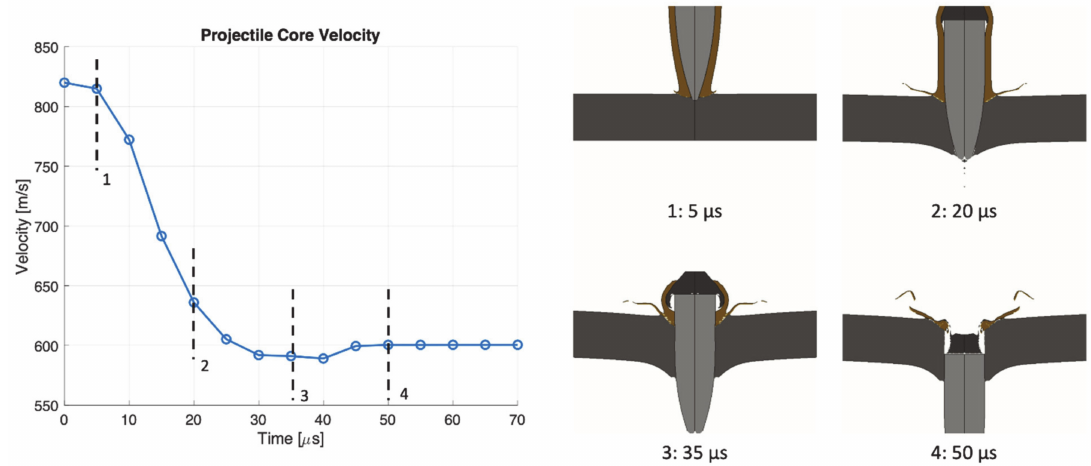
Figure 13. Perforation process in target S at 820 m/s impact velocity. The energy absorbed by the target S at 820 m/s impact velocity is shown in Figure 14.